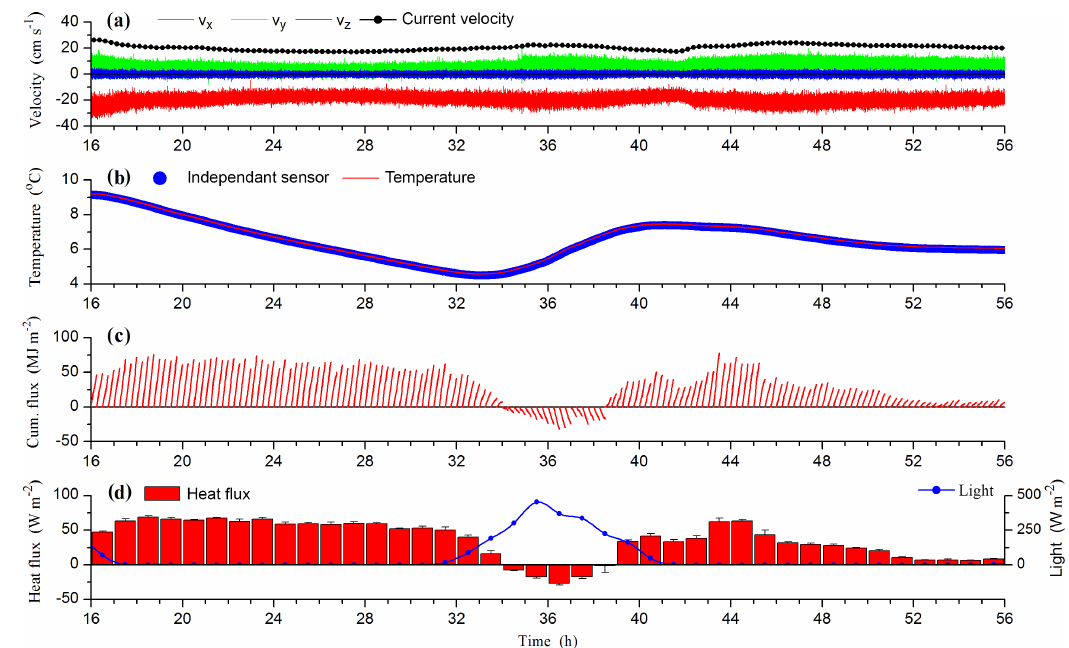
Figure 3. The same deployment as in Fig. 2, but with results for temperature and heat. The deployment was initiated at 16:00LT in the afternoon as indicated on the x axis. (a) Three velocity components at 8Hz ( x , y , z ; z is vertical) and 15min mean current velocity. (b) Temperature at 8Hz measured with the dual O 2 –temperature sensor and at 1min measured with an independent sensor. (c) Cumulative flux over 15min time intervals with clear linear trends. (d) Hourly heat flux, each value based on 15min flux extractions ( n = 4, SE) and day light measured at a nearby weather station. Positive flux values represent a release of heat from the